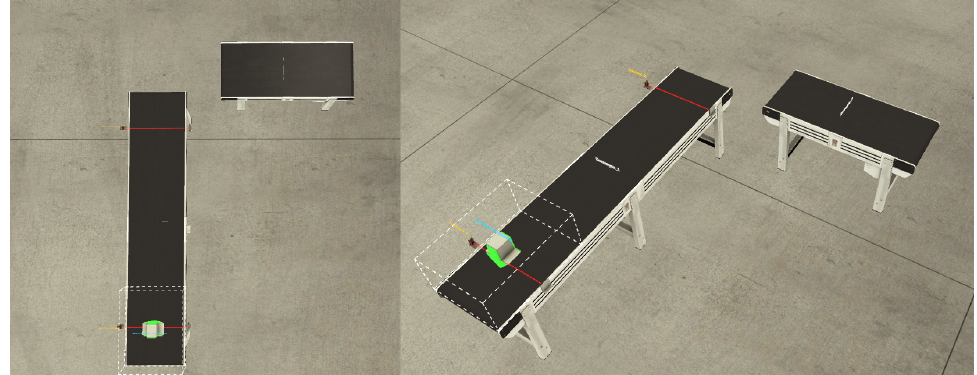
Figure 25. Fragment of discrete-event